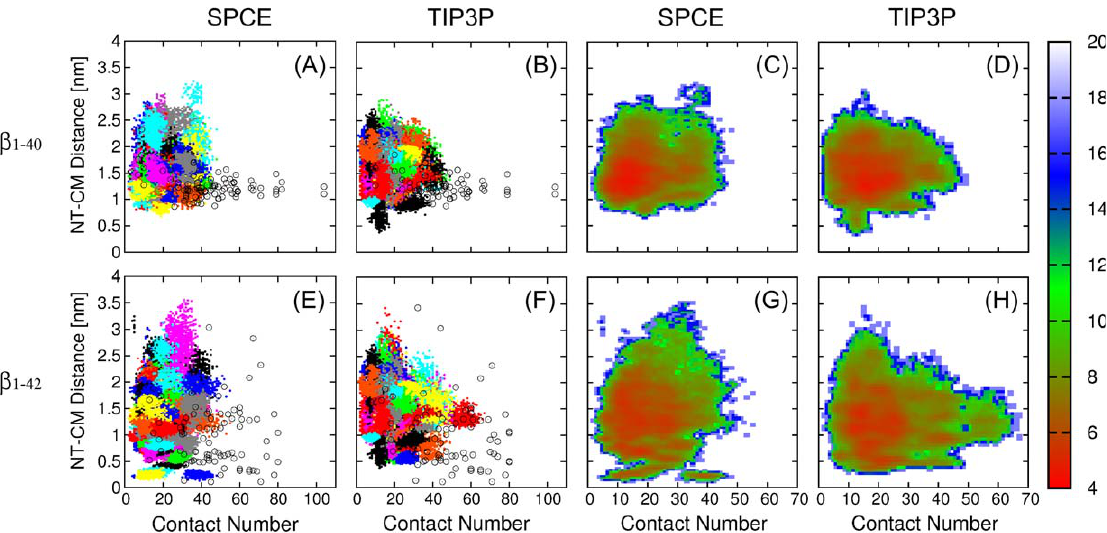
Figure 2. Sampling efficiency and free energy landscapes of A b dimers. Dimer conformations of all acquired MD trajectories of (A,B) A b 1 { 40 and (E,F) A b 1 { 42 , respectively, projected onto two reaction coordinates, for the (A,E) SPCE and (B,F) TIP3P water models. Each trajectory is shown in one color and each point corresponds to one dimer conformation along the trajectory acquired at simulation times 20–50 ns. The open black circles correspond to the initial DMD-derived dimer conformations. The PMF plots for (C,D) A b 1 { 40 and (G,H) A b 1 { 42 dimers calculated from MD trajectories with the (C,G) SPCE and (D,H) TIP3P water model. The color scheme to the right of each plot is given in units of k B T. Images were created by the GNUPLOT software package.